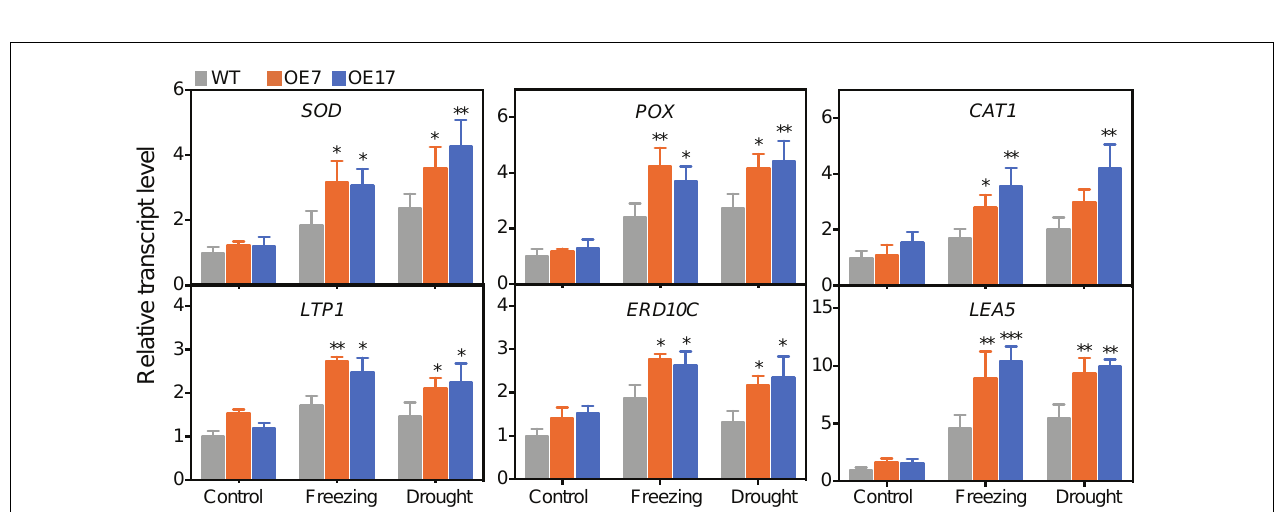
FIGURE 8 | Expression levels of stress-responsive genes in wild type (WT) and 35S:CbABF1 transgenic plants under freezing and drought conditions. Four-week-old wild-type and transgenic (OE7 and OE17) tobacco plants were subjected to cold (–2 ◦ C for 5 h) and drought (shoots were placed on filter papers and allowed to dry for 5 h). Tobacco leaves were collected to detect expression levels of the genes via qRT-PCR. NtEF1- α (AF120093) was used as the internal control. Data represent mean values ( ± SD) from three independent replicates. Asterisks indicate statistical significance between the transgenic and WT plants ( ∗ P < 0.05, ∗∗ P < 0.01, ∗∗∗ P < 0.001, two-way ANOVA Tukey test). Three biological experiments were performed, which produced similar results.